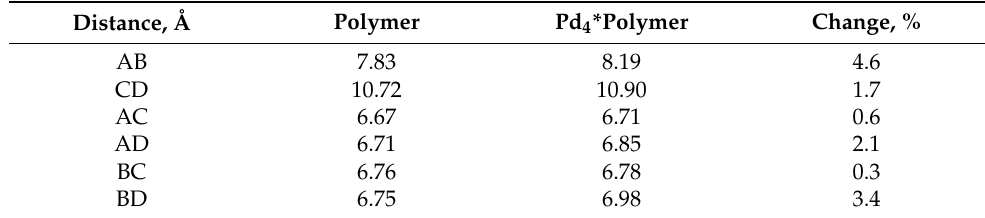
Table 4. Structure parameters of the polymer micropore in case of Pd 4 incorporation.